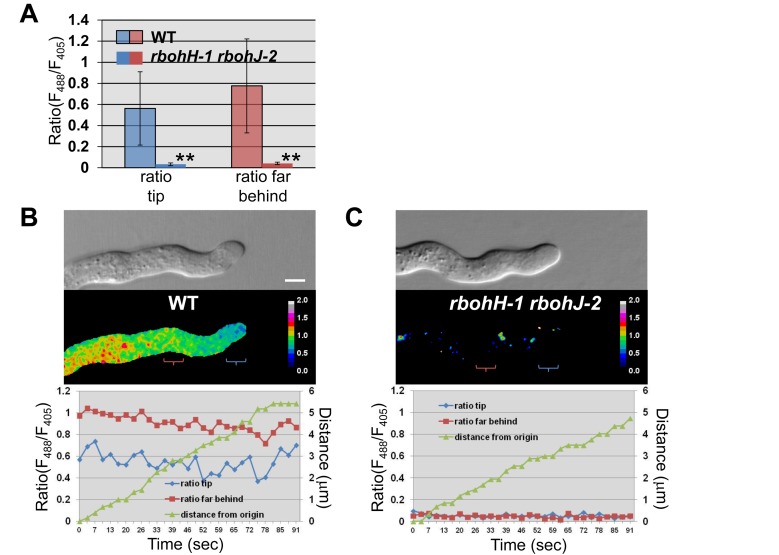
H2O2-sensitive HyPer sensor ratiometric imaging shows that RbohH and RbohJ are responsible for H2O2 production at the tip of growing pollen tubes.(A) Quantification of HyPer ratio (F488/F405) at the tip and further back in the shank of growing WT (n = 27) and rbohH-1 rbohJ-2 (n = 22) PTs. Data are shown as the mean of ratios over 90 seconds±standard deviation (SD). Double asterisks indicate significant differences from the WT according to a Student's t test with p<0.01. (B) Representative images of a growing WT PT expressing cytosolic HyPer and the corresponding histogram displaying the ratios (F488/F405) at the tip (blue line) and behind the tip (red line) over 90 s, as well as the travelled distance of the PT tip (green line). The blue and red parentheses indicate where the circles of 4 µm diameter were positioned for measurements at the tip and behind the tip, respectively. See corresponding Video S4. Scale bar = 5 µm. (C) Representative images of growing rbohH-1 rbohJ-2 PT expressing cytosolic HyPer. See (B) for details.